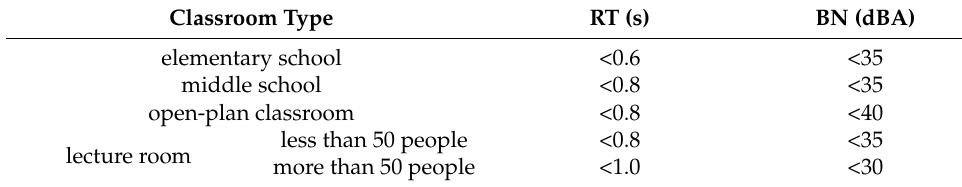
Table 2. Acoustic performance standards for classrooms in the United Kingdom (unoccupied).